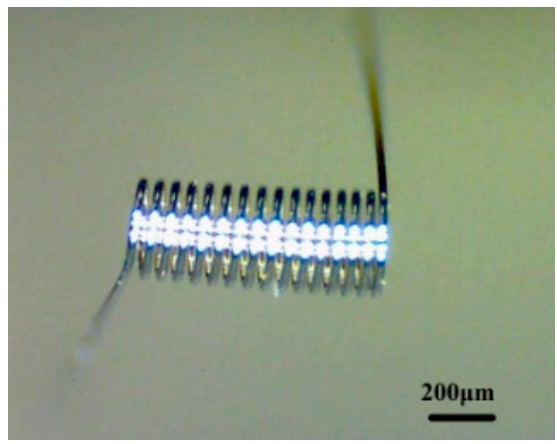
Figure 2. Structure of platinum